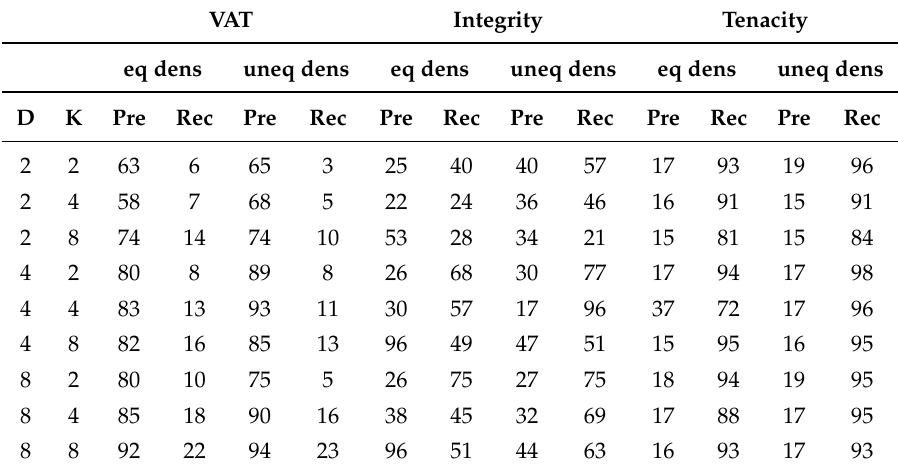
Table 8. Precision and Recall (in Percentage) of Hierarchical NBR Clustering Noise Removal on Noisy Synthetic